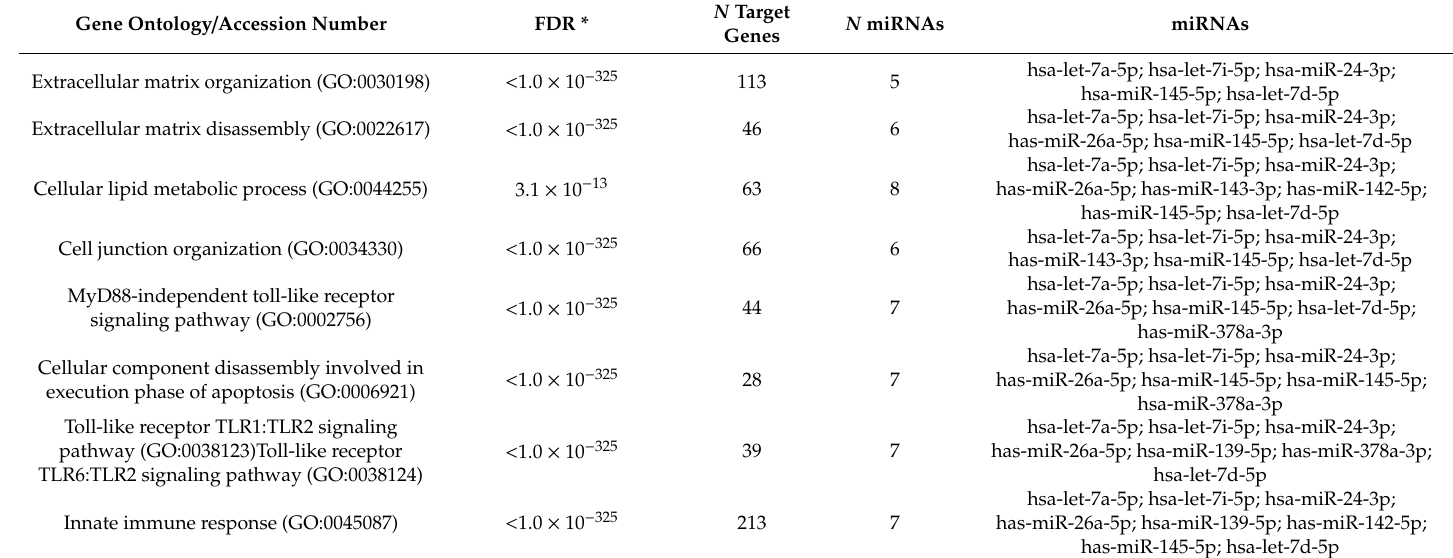
Table 4. Significant, enriched Gene Ontology terms for di ff erentially-expressed miRNAs in relation to backfat